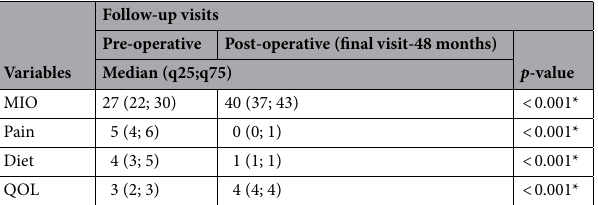
Table 3. Clinical outcomes of TMJ arthroscopic discopexy. * p < 0.001 (Wilcoxon signed ranked test).